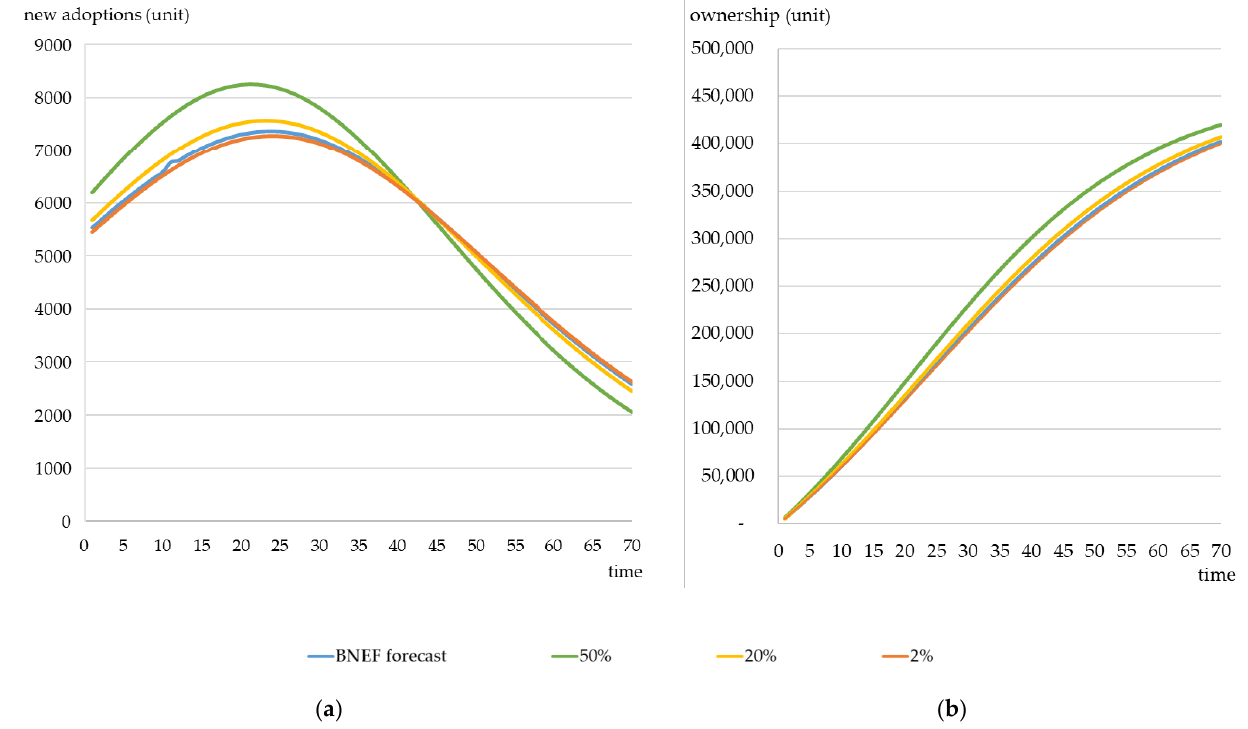
Figure 6. ( a ) In the scenario with a 10% replacement rate, the numbers of new adoptions, which are simulated in accordance with the BNEF estimation, involve annual drops of 50%, 20% and 2%; ( b ) In the scenario with a 10% replacement rate, the numbers of new adoptions, which are simulated in accordance with the BNEF estimation, involve annual drops of 50%, 20% and 2%.